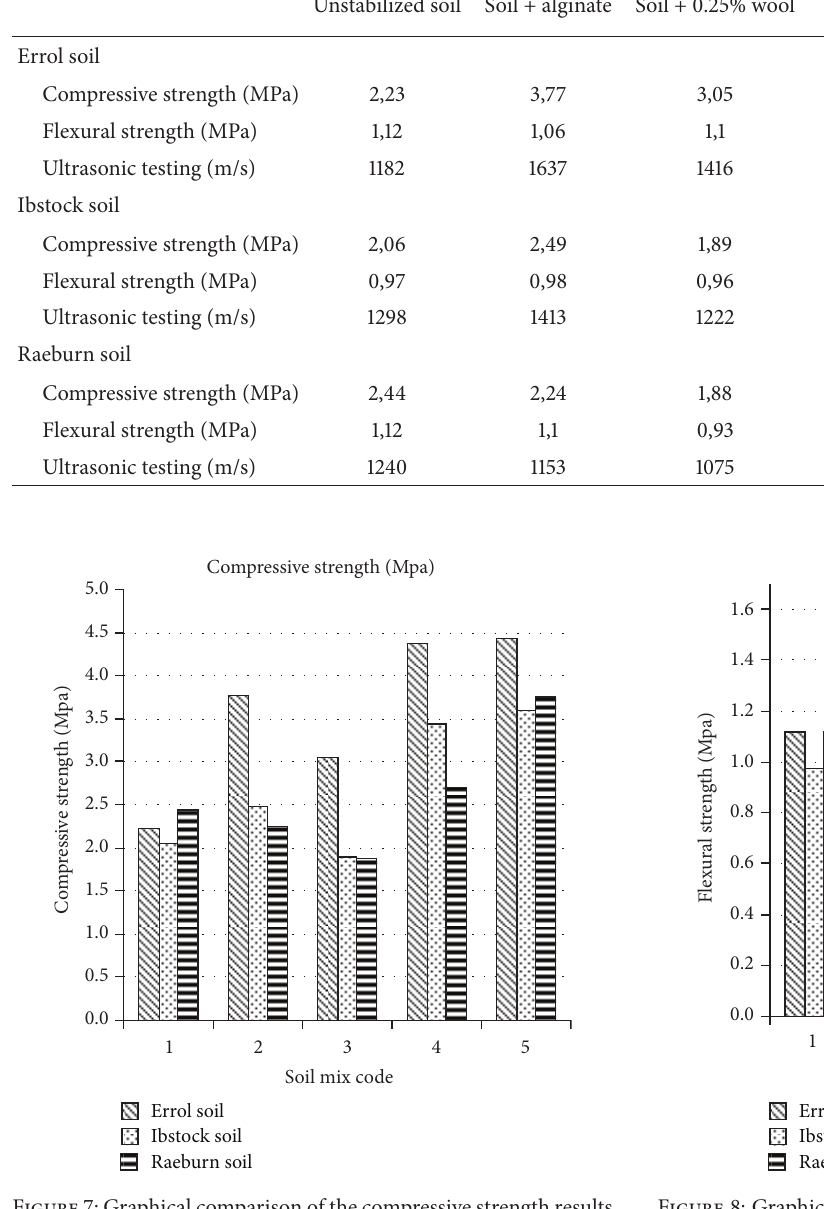
Figure 8: Graphical comparison of the flexural strength results on the five different mixes of the three types of